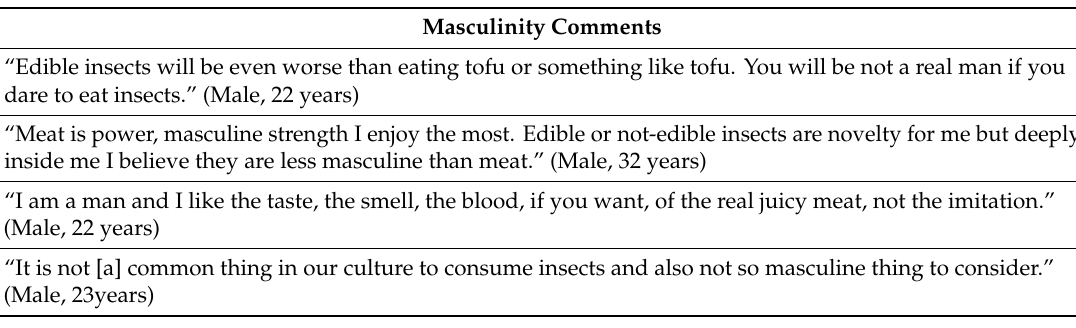
Table 4. Psychological factor: masculinity.